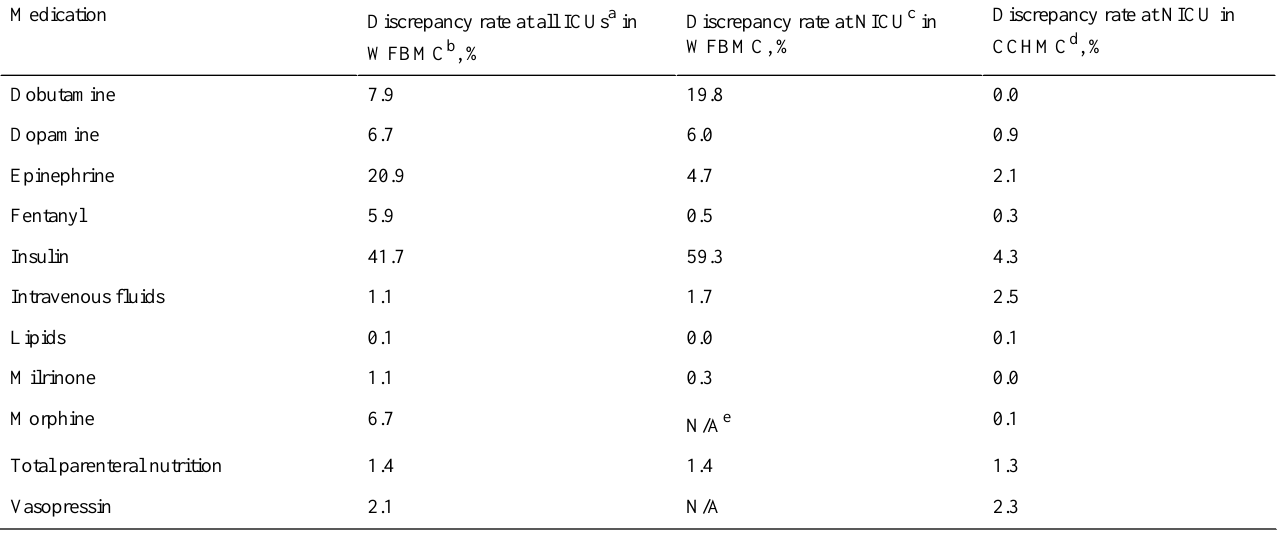
Table 2. A comparison of medication administration discrepancy rates generated by MED.Safe at Wake Forest Baptist Medical Center and Cincinnati Children’s Hospital Medical Center during the study period.